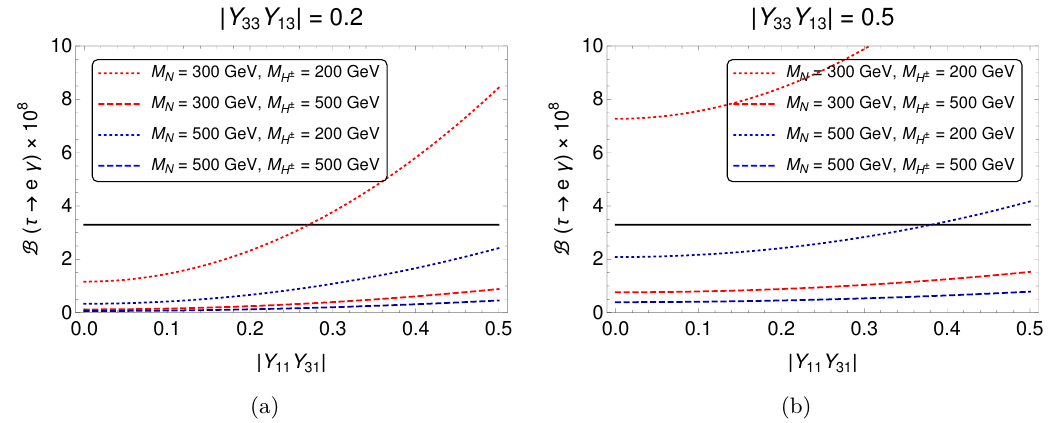
Figure 16 . Variation of B ( τ → eγ ) with the coupling combination | Y 11 Y 31 | for two different values of RHN mass M N ≡ M N = M N (red and blue). For a fixed M N , we have also shown the variation 1 3 with respect to the charged Higgs mass M by dotted and dashed legends. The black solid line H ± is the experimental upper limit on the branching